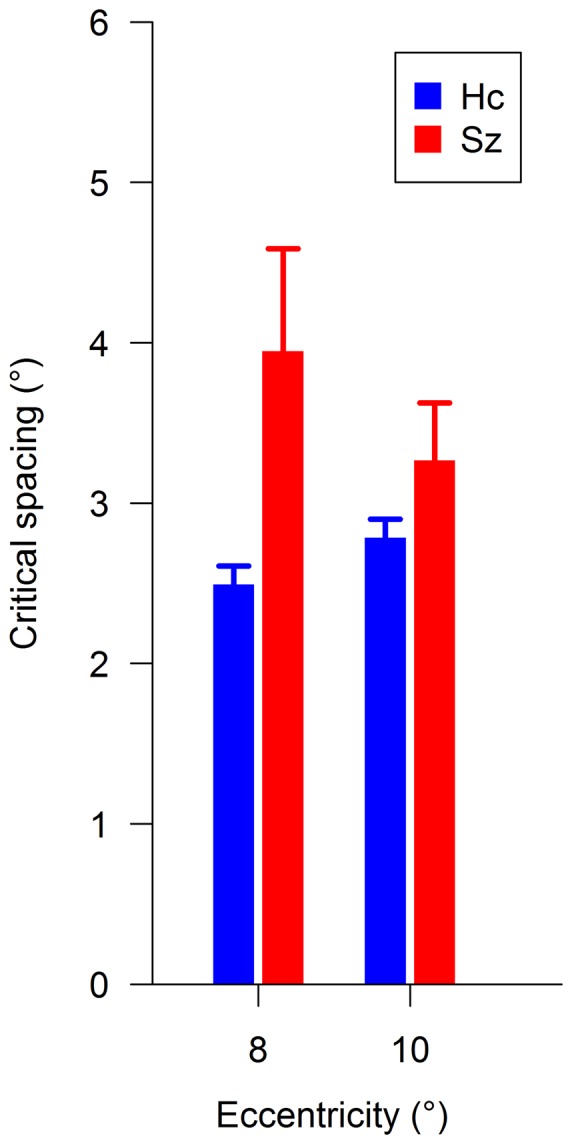
Mean critical spacing for schizophrenia patients (Sz) and healthy controls (Hc) by eccentricity.Critical spacing was larger in the schizophrenia group than in the control group. Error bars represent the standard error of the mean.